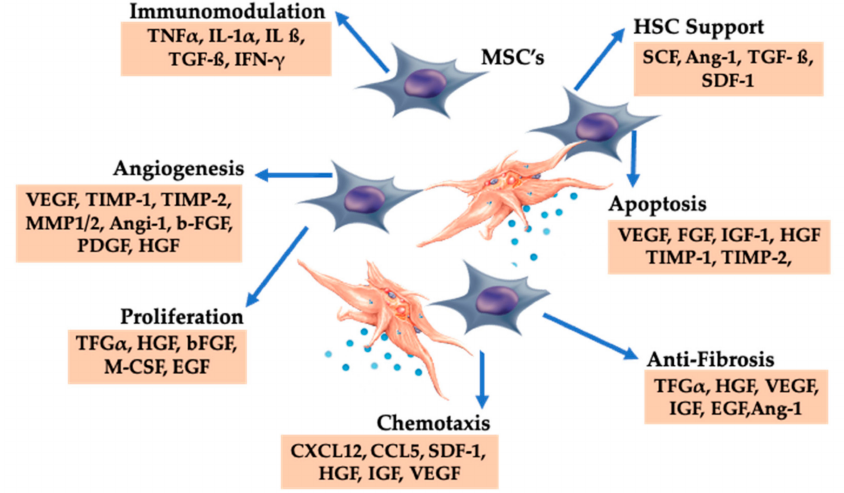
Figure 6. Platelet-derived growth factors and dense granular constituents are expressively involved in BMAC trophic processes, supporting MSC induced tissue repair and regeneration. Abbreviations: MSC: mesenchymal stem cell, HSC: hematopoietic stem